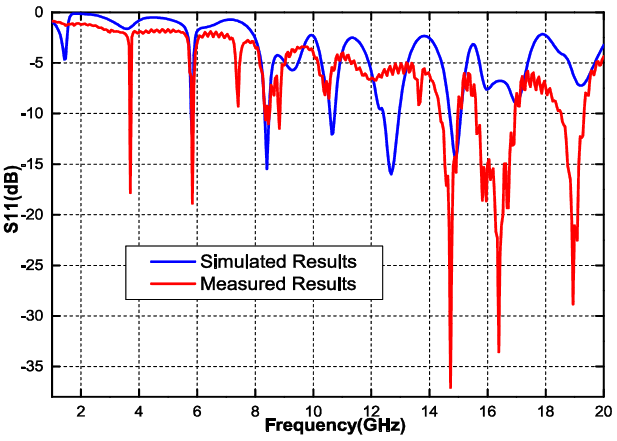
Figure 13: simulated and measured return loss